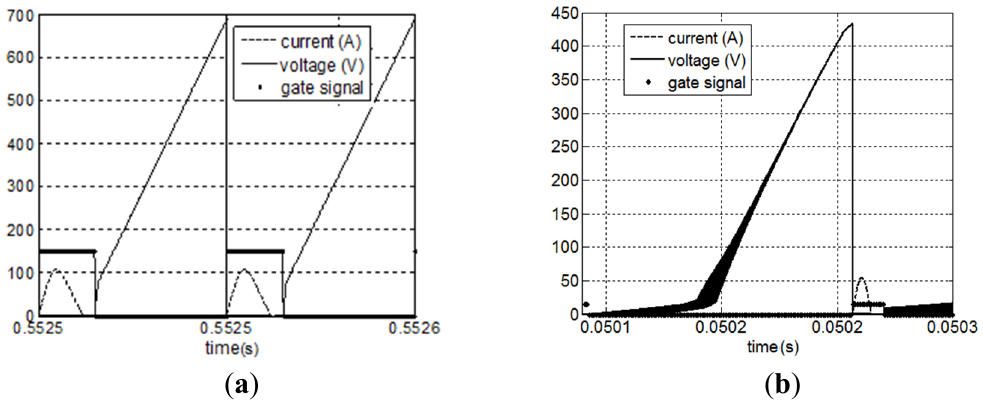
Figure 20. Voltage and current signals on controlled semiconductor device; ( a ) v wind = 12 m/s; ( b ) v wind = 3